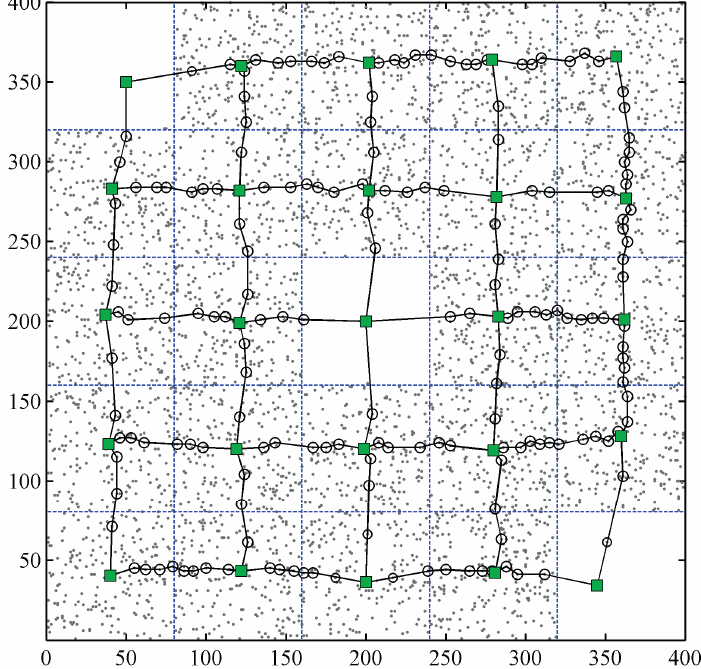
Figure 4. An example of global control network in the case of few PSs being available in several grids. Only one or two PSs are located in the top-left and bottom-right grid, respectively, and there is no PS in the central